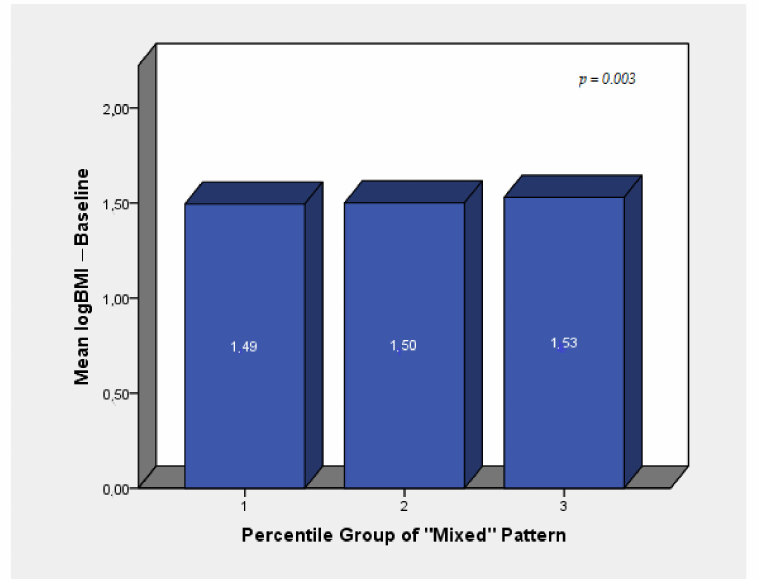
Figure 4. Percentile distribution and associations between the “Mixed” Pattern and logBMI values.